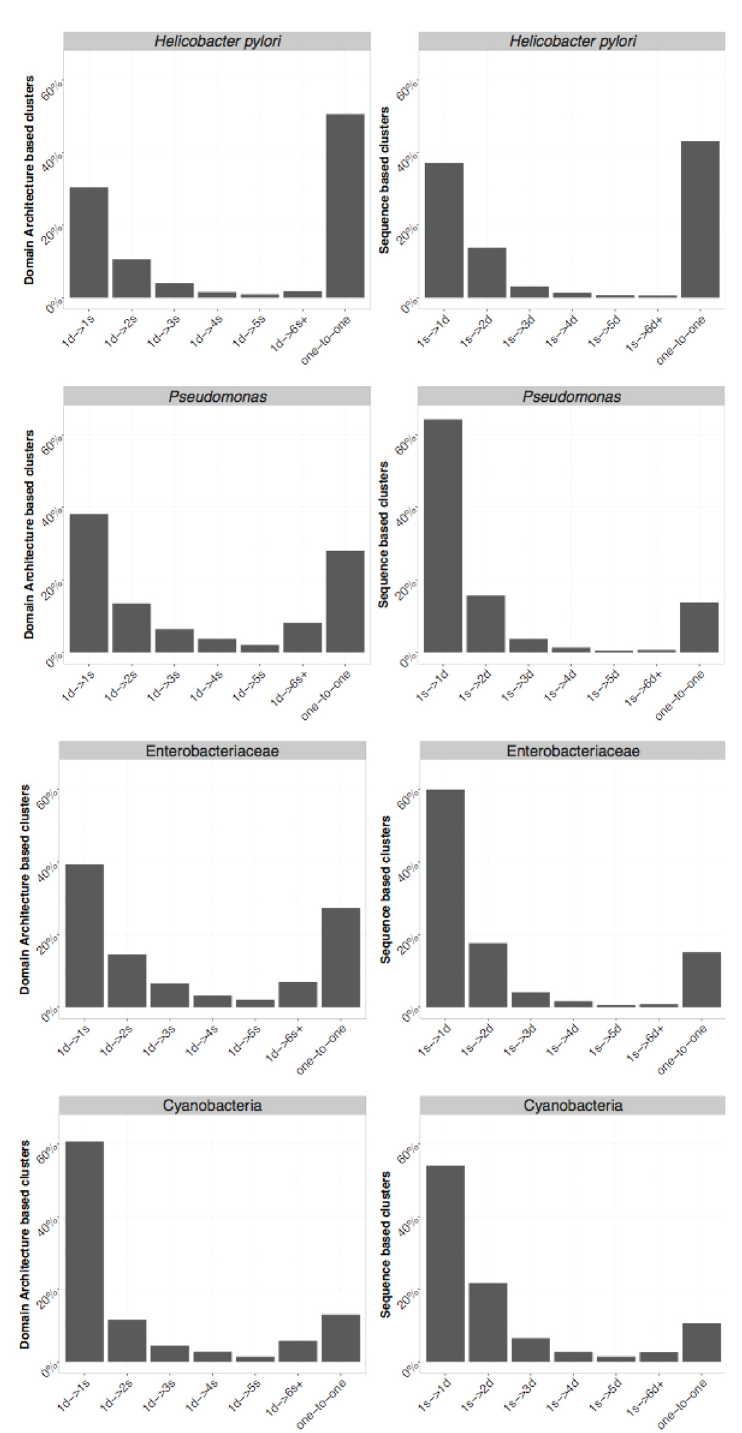
Figure S3. Comparison between DAB and SB clusters. On the left DAB is used as a reference and each bar represents the relative frequency of one DAB cluster containing sequences assigned to {1, 2, . . . , 5} and 6 or more SB clusters and one-to-one represents the relative frequency of identical cluster. Similarly, on the right SB is used as a reference. Axis labels follow notation in Figure 5.